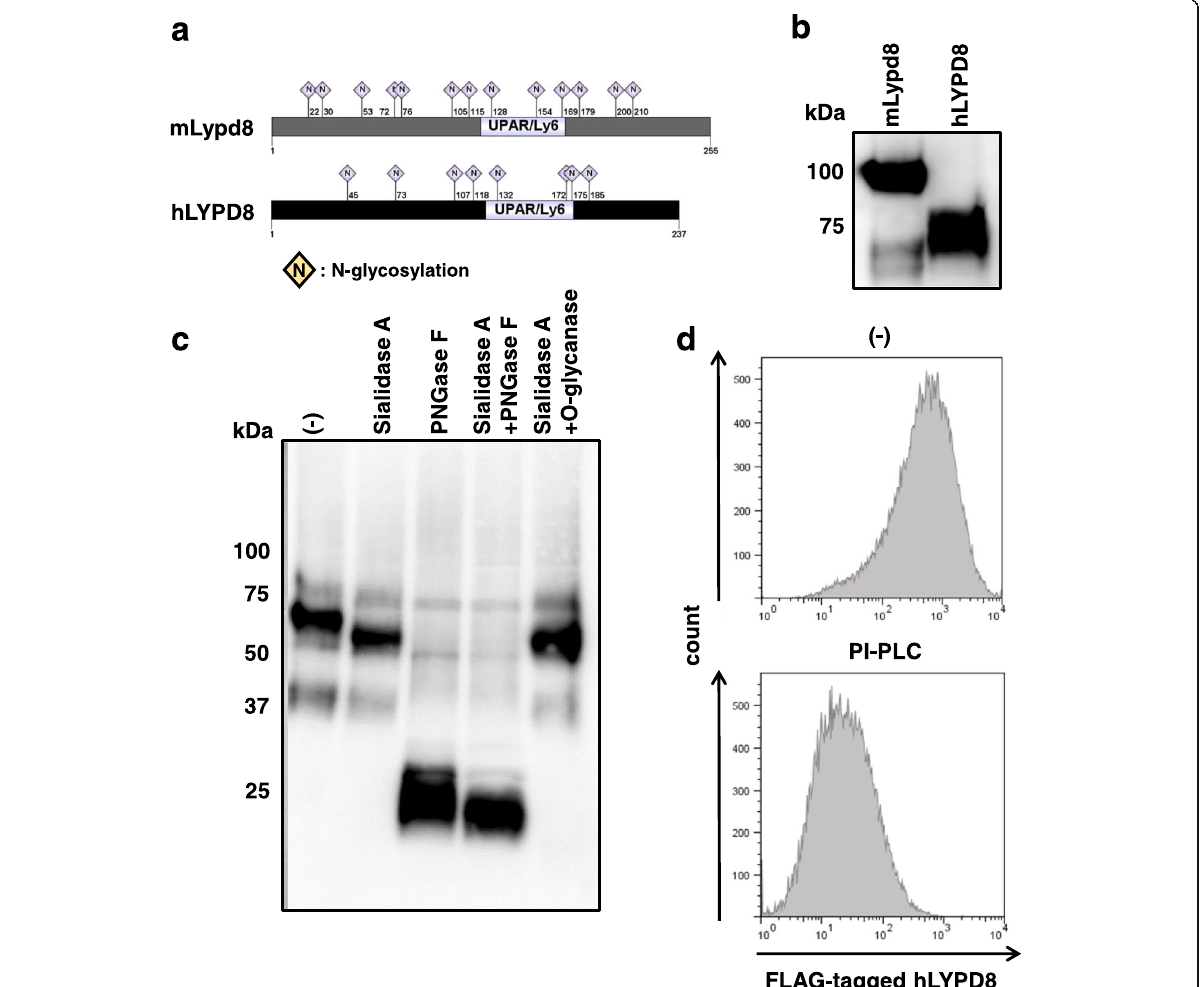
Fig. 1 Molecular characteristics of the hLYPD8 protein. a Predicted glycosylation sites of the mLypd8 and hLYPD8 proteins. Glycosylation sites were referred to the UniProt database, and the picture was drawn by a group-based predictive system (IBS 1.0.2). b Immunoblotting for whole cell lysates of HEK293T cells expressing mLypd8 and hLYPD8. c Immunoblotting for recombinant hLYPD8 protein untreated or treated with sialidase A, PNGase F, or O -glycanase. d Flow cytometric analysis of HEK239T cells expressing FLAG-tagged LYPD8 before (upper) and after